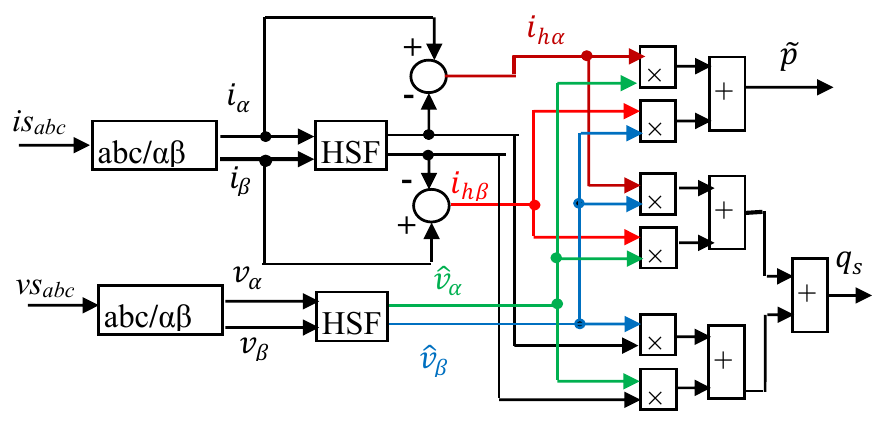
, v , 𝑝̃ & q with HSF. α β s